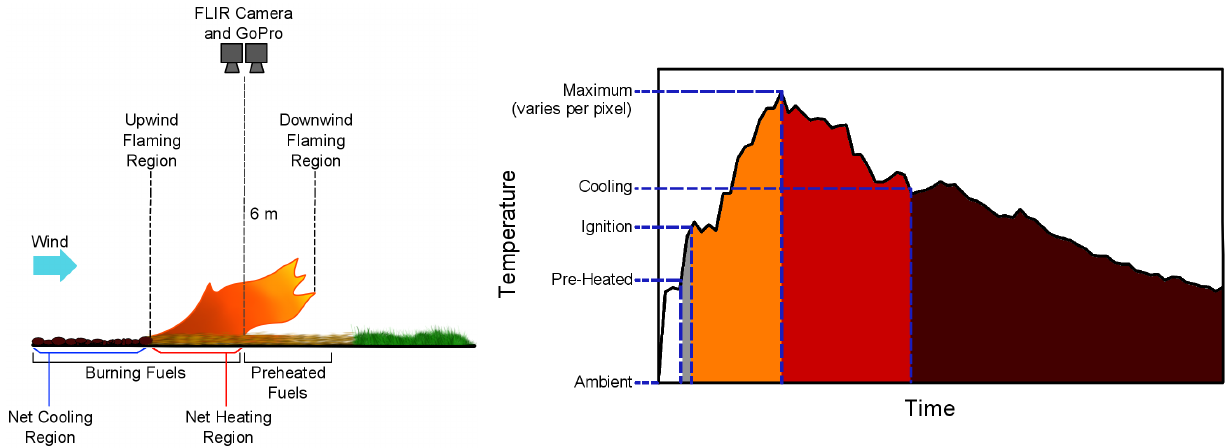
Figure 4. ( Left ): A schematic of the experimental setup. The RoS of the upwind side of the flaming region is tracked. ( Right ): A typical time series of a pixel. The colors coincide with those in Figure